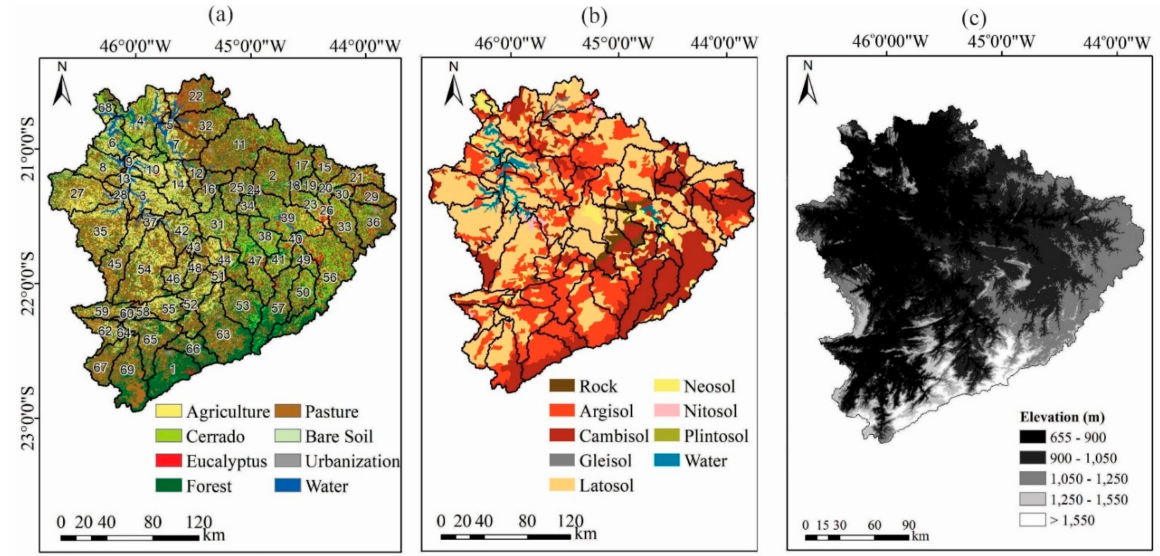
Figure 2. ( a ) Land-use map with the sub-watersheds used in the Lavras simulation of hydrology (LASH) calibration; ( b ) soil map; ( c ) the digital elevation model of the